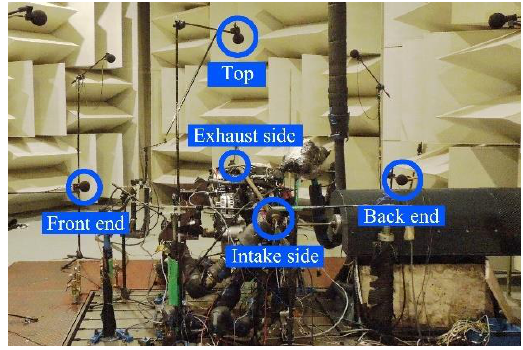
Figure 18. The positions of the microphones in the noise experiments.